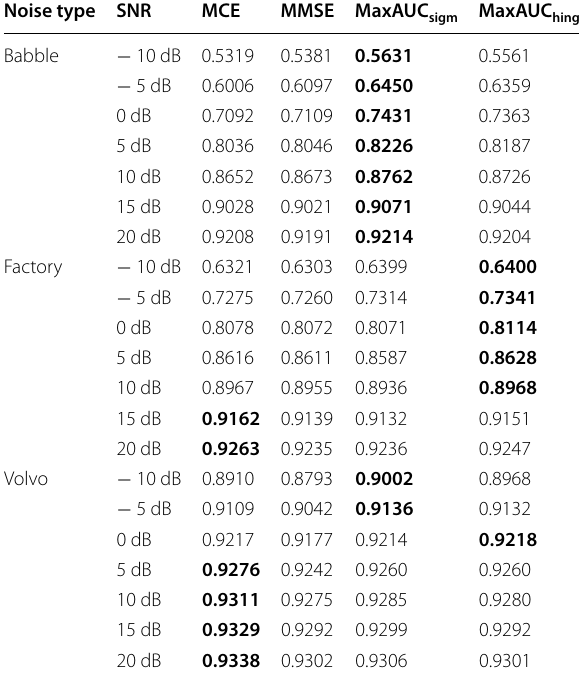
Table 2 AUC results of the comparison VADs with the feedforward neural network and STFT acoustic feature on the English Noisy‑CHiME‑4 test dataset. We use the names of the objectives of the VADs to represent the VADs for